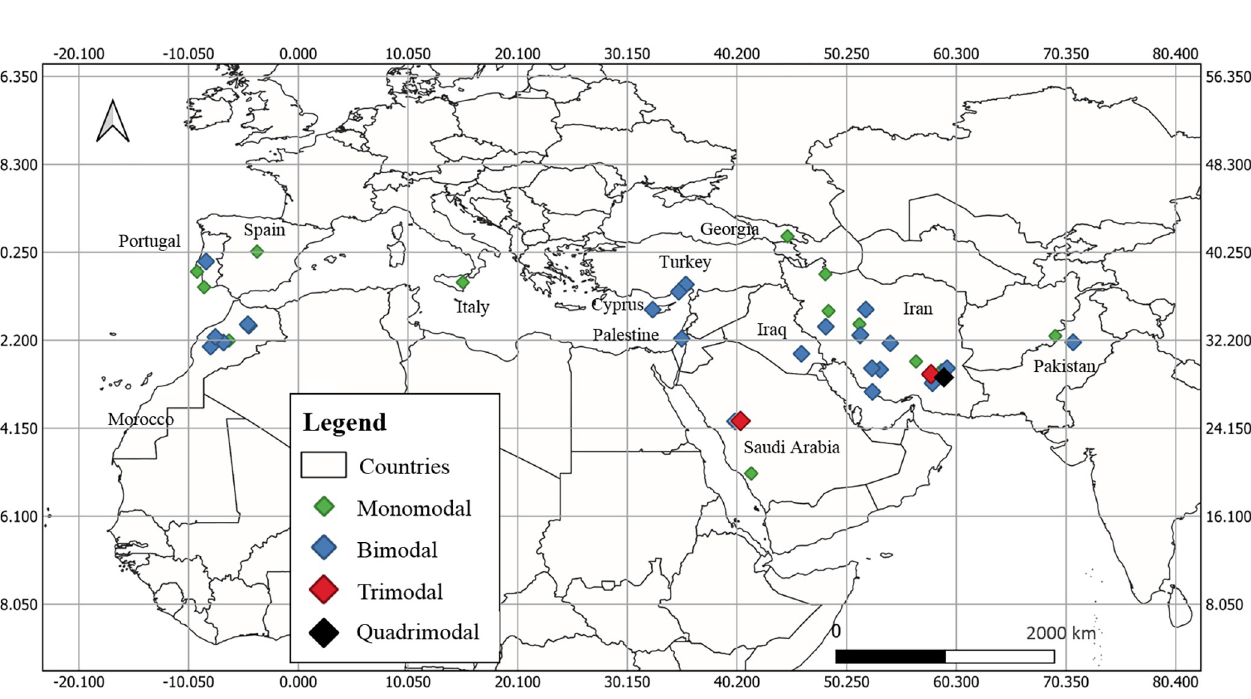
Fig 3. According to data collected on seasonal activity investigation, the geographic distribution of P . (Par . ) sergenti . A Mono-modal, bimodal or trimodal distribution of the normalized sand fly activity has been recorded from data extracted from 35 published scientific works. Boundaries were adapted and modified from Open Data Soft https://public.opendatasoft.com/explore/dataset/world-administrative-boundaries/export/.